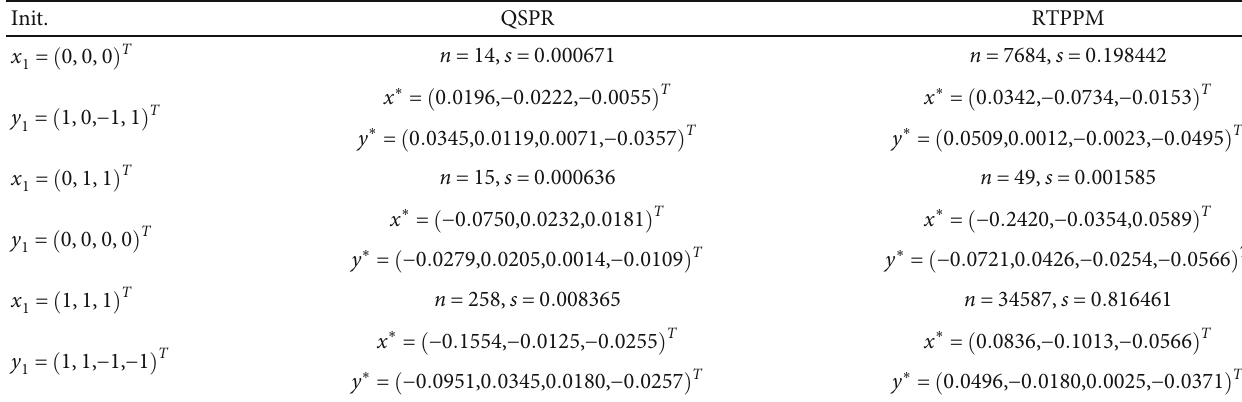
Table 1: The numerical results of Example 8.